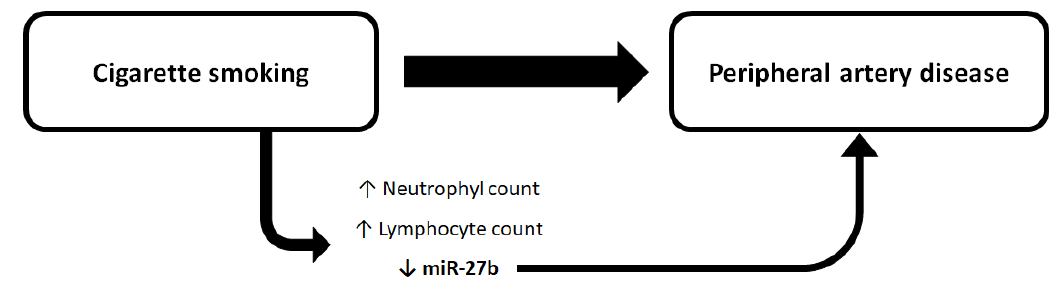
Figure 2. Putative role of miR-27b in the toxicity induced by cigarette smoking. Cigarette smoking was associated with the presence of peripheral artery disease and with miR-27b downregulation; downregulation of the atheroprotective miR-27b was associated with the presence and severity of peripheral artery disease; miR-27b may mediate the atherogenesis induced by cigarette smoking. The suspension points represent metabolic and inflammatory parameters potentially dysregulated in association with cigarette smoking, in addition to neutrophil count, lymphocyte count, and miR-27b ex- pression.